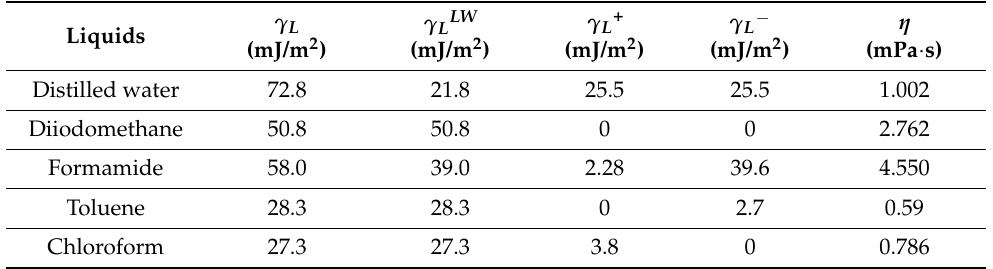
Table 2. Surface free energy( γ L ), Lifshitz-van der Waals force( γ LLW ), Lewis acid force( γ L+ ), Lewis alkali force( γ L − ), and viscosity( η ) of test liquid for polypropylene.